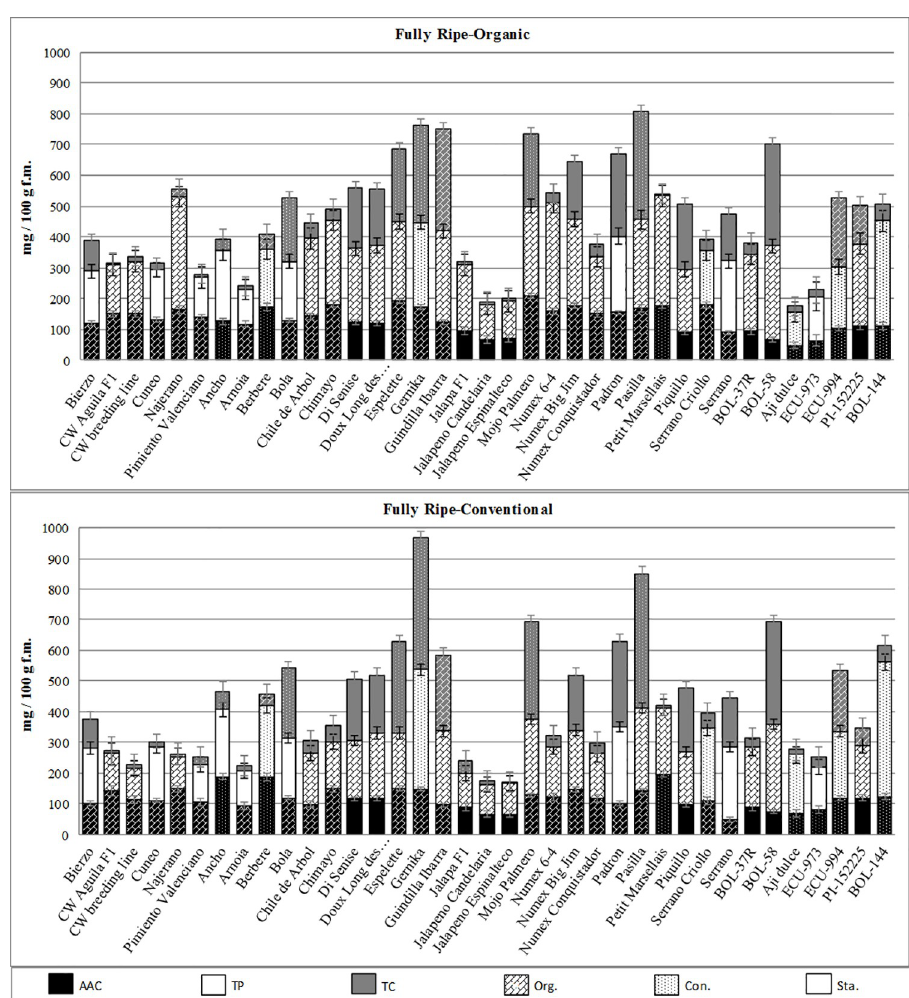
Fig 3. Comparison among accessions at the fully ripe stage considering ascorbic acid content (AAC), total phenolics (TP) and total carotenoids (TC R +TC Y/O ) under organic (upper) and conventional (bottom) growing systems. Texture of columns, based on β parameter, indicates better response to organic (Org.), conventional (Con.) or stable behaviour (Sta.). Bars on the top of columns indicates standard error